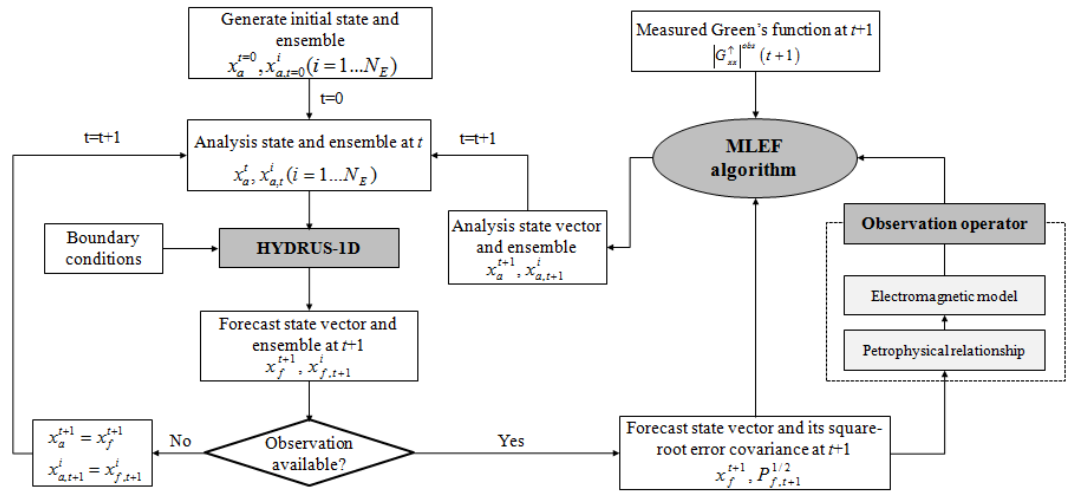
Fig. 1. Assimilation procedure using GPR data to update the state of the soil moisture profile.